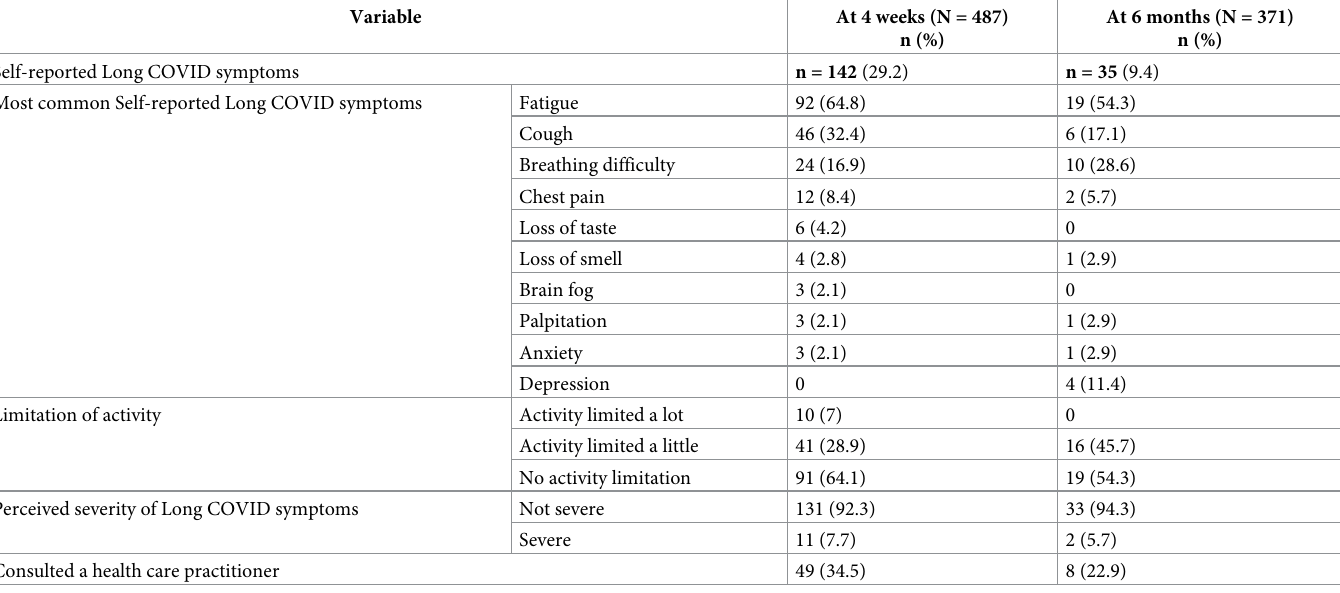
At 6 months (N = 371) n (%) n (%)